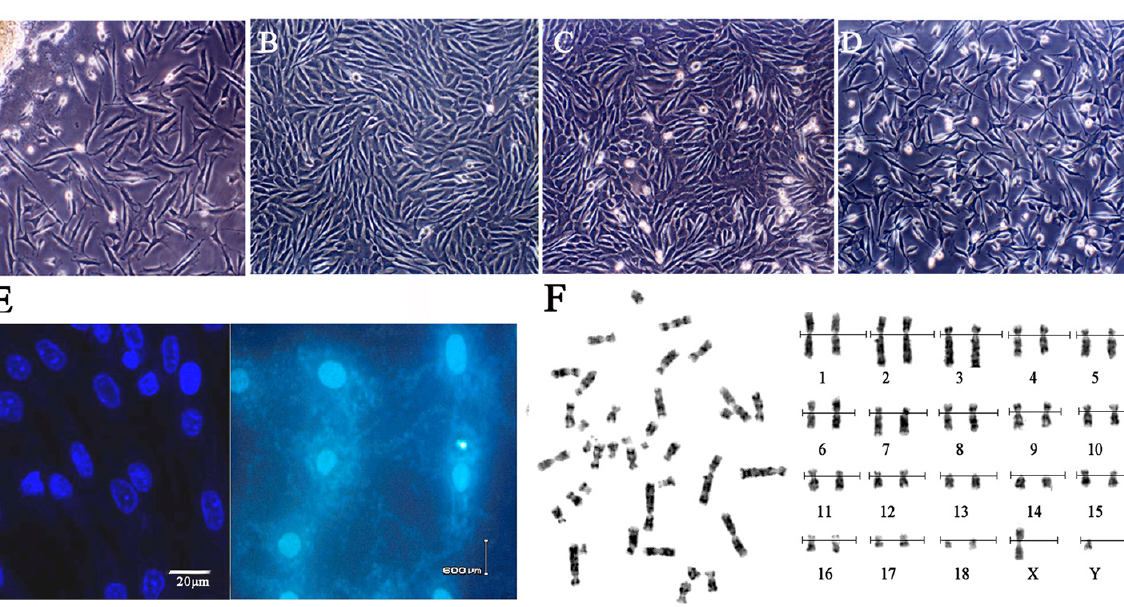
Figure 1. Morphology, Mycoplasma contamination and karyotype of Siberian tiger cell line. ( A ) Primary cells (100×), the cells were typical long spindle-shape; ( B ) Subcultured cells (100×); ( C ) Cells before cryopreservation (100×); ( D ) Cells after recovery (100×); ( E ) Mycoplasma detection for fibroblasts stained with Hoechst33258 and positive control of Mycoplasma contamination; ( F ) G-band chromosome at metaphase ( Left ) and karyotype ( Right ) ( ♂ ,